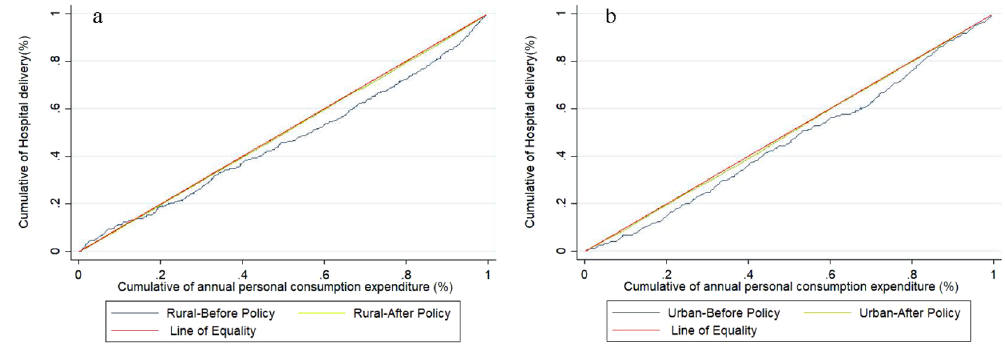
Table 4. Contributions of factors and horizontal inequity of women’s hospital delivery before and after China’s Rural Hospital Delivery Subsidy policy (n = 2398). 1 Concentration Index. 2 Pure percentage contributions of determinants to the socioeconomic inequality in hospital delivery. 3 Including age, health score and chronic disease. 4 Including women’s prenatal visits during pregnancy, health insurance, parity, education and